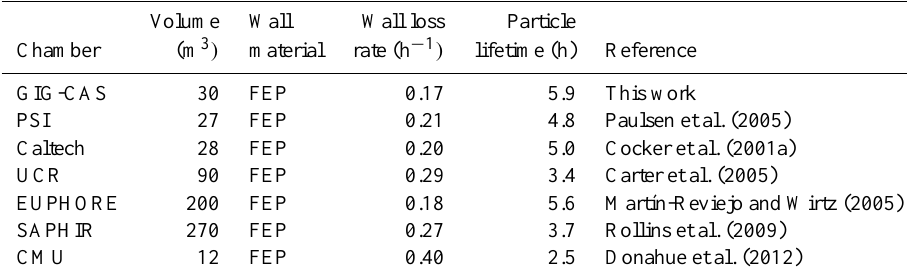
Table 3. Comparison of particle wall loss rates in different smog chambers.